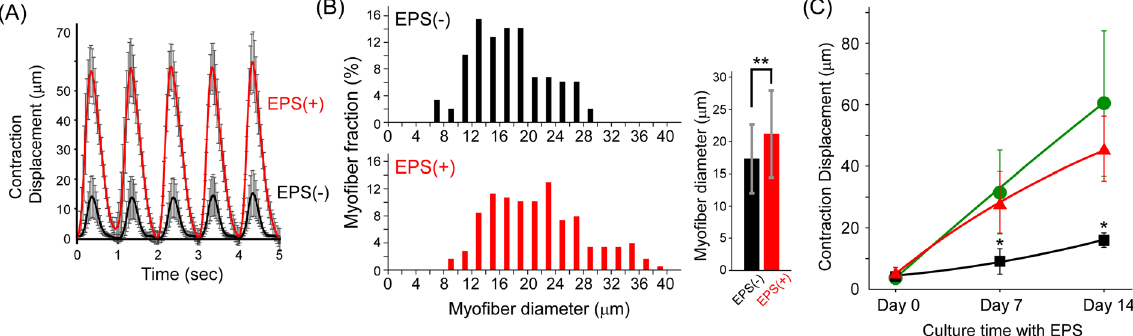
Figure 5. Effect of EPS-induced continuous contraction on maturation of myofiber sheets. ( A ) Contraction displacement of myofiber sheets cultured with no stimulation for 10 days (EPS( − )) and with no stimulation for 7 days and then continuous stimulation for 3 days (EPS( + )). Continuous EPS (voltage: 10 V, frequency: 1 Hz, duration: 3 ms) was applied for 1 h with 3 h rest. This procedure started at day 7 after induction of differentiation and was repeated for 3 days. To compare their contraction abilities, EPS was applied at 1 Hz frequency for 5 seconds. (n = 3) ( B ) Distribution and average value of myofiber diameters with and without continuous EPS for 2 weeks. The data were summarized from three myofiber sheets for each group (total number of myofibers: more than 150). ( ** P < 0.01) ( C ) Effect of continuous EPS on contractile ability of myofiber sheets for 2 weeks. Two different continuous EPS (triangle: 3 ms, circle: 10 ms) were applied for 1 h with 3 h rest. This procedure started at day 7 after induction of differentiation (Day 0 for EPS exercise) and was repeated for 2 weeks (Day 14). As the control, myofiber sheets were cultured without continuous EPS (square). The displacements of the shortening myofibers were monitored at Day 0, 7, and 14. (n = 5) ( * P < 0.05 vs other samples at the same time point).